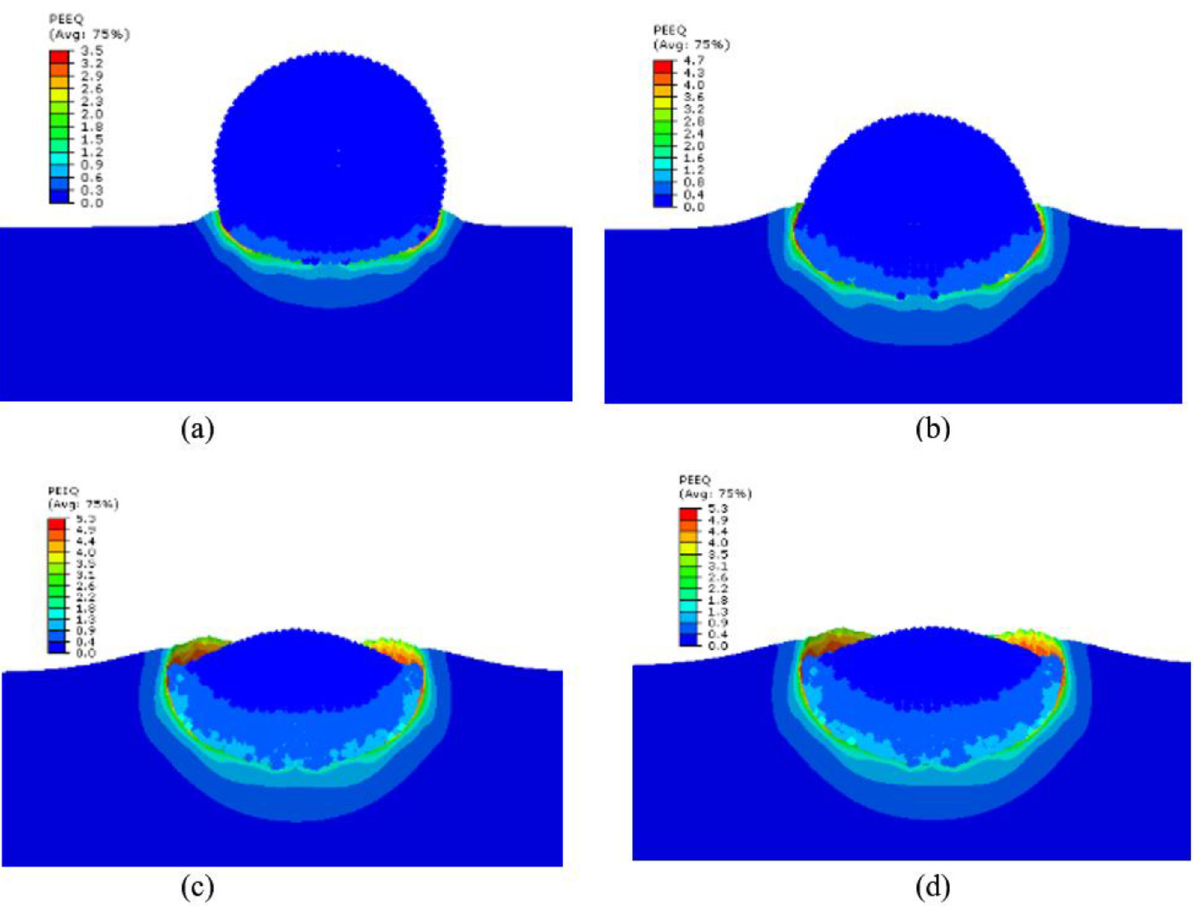
Fig. 5. The distribution of PEEQ of various impact time at 500 m/s Cu/Al impact (a) 5ns (b) 10 ns (c) 20 ns (d) 30ns by using the SPH numerical modelling.